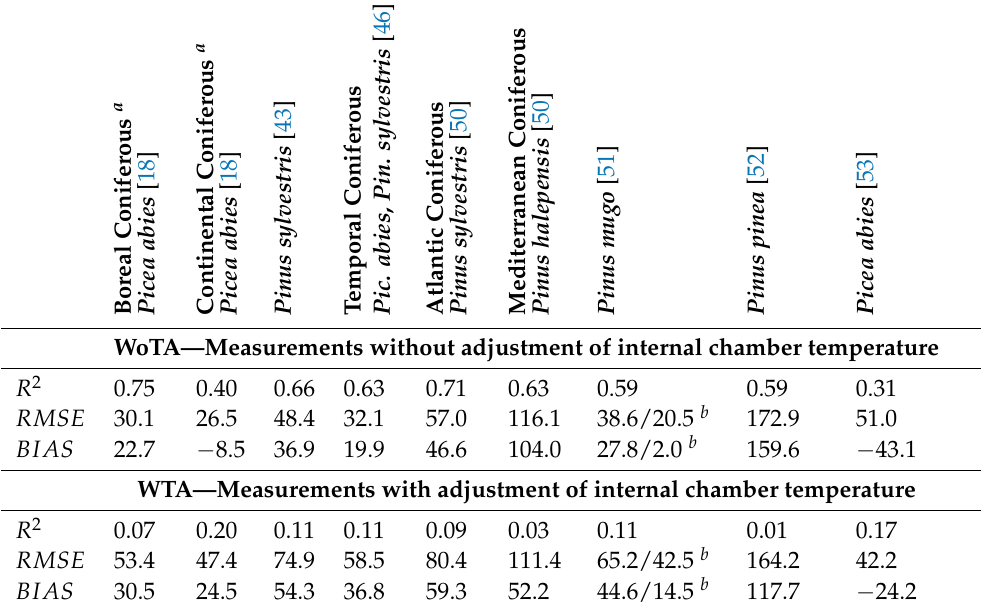
Table 4. Validation of the modified Jarvis model against WoTA and WTA measurements of stomatal conductance for each set of static parameters adopted from the literature in Table 2.